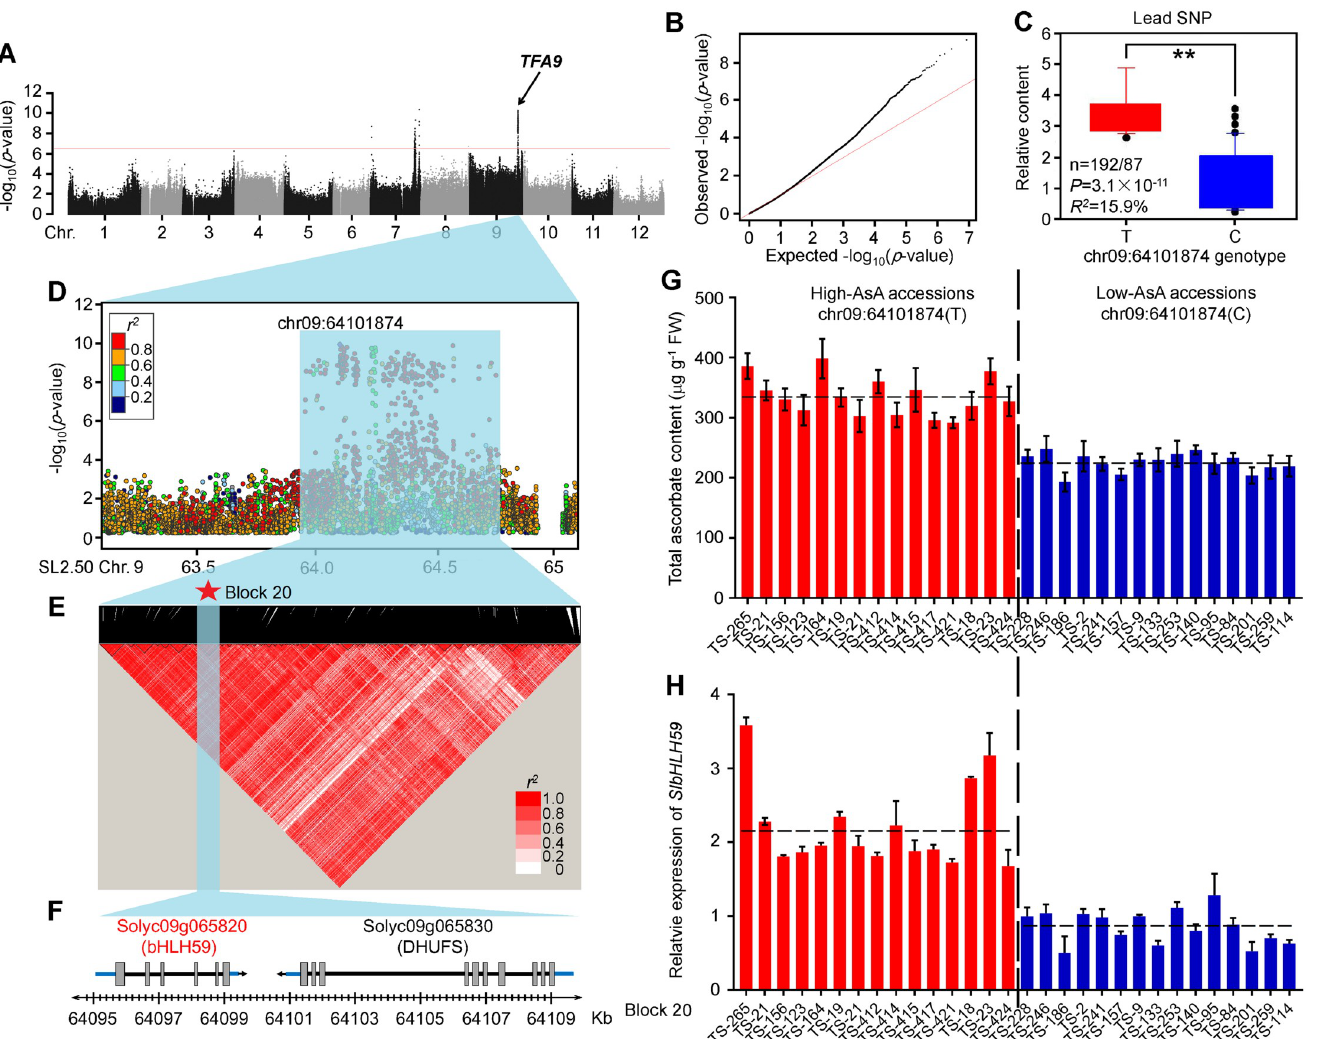
Fig 2. Genome-wide association results for ascorbate content in tomato fruits. (A) Manhattan plot displaying the GWAS results for ascorbate content in fruits (CMLM, N = 302). Negative log 10 -transformed P values from the compressed mixed linear model are plotted on the y- axis. Horizontal dashed line indicates a genome-wide suggestive threshold of 2.4 × 10 − 7 . (B) Quantile-quantile plot for ascorbate content in the GWAS population. (C) Box plot for ascorbate content, plotted as a function of genotypes at SNP ch09_64101874. The metabolic data for ascorbate were log 2 transformed. (D) Detailed plot from 63.1–65.1 Mb on chromosome 9 ( x- axis). Lead SNP is indicated in purple. A representation of pairwise r 2 values (a measure of LD) among all SNPs in region 63.1–65.1 Mb, where the colour of each box corresponds to the r 2 value according to the legend. (E) A representation of the pairwise r 2 values (a measure of LD) among all polymorphic sites in the 830 kb genomic region corresponding to (D) , where the darkness of the color of each box corresponds to the r 2 value according to the legend. The 145 haploblocks are represented by inverted triangle. Haploblock 20 (marked by red star) contains Lead SNP associated with fruit AsA content. (F) Gene structure of two genes in the haploblock 20. Filled grey, blue and blacklines represent coding sequence, promoter & 3’UTR and introns respectively. (G, H) The ascorbate content (G) and relative expression of candidate gene ( SlbHLH59 ) (H) in fruits from different selected accessions. Data represent means ± s.d. (n = 3). The dashed horizontal lines represent the average ascorbate content and expression levels of SlbHLH59 in fifteen low-AsA accessions and fifteen high-AsA accessions.